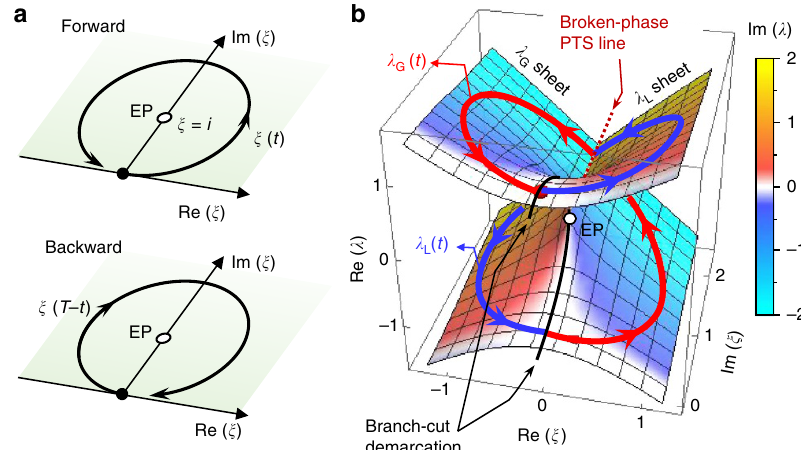
Figure 2 | Optical eigensystem characteristics of the unidirectional converter region. ( a ) Complex x trajectories for the forward (upper) and backward (lower) propagation cases. ( b ) Complex eigenvalue spectra and instantaneous eigenvalue trajectories on the complex x space. The wireframe surface and surface skin colour indicate real and imaginary parts, respectively. The instantaneous eigenvalue trajectories are calculated for the circular x ( t ) trajectory in a . Arrows on the trajectory curves indicate the direction of the parametric change with time t